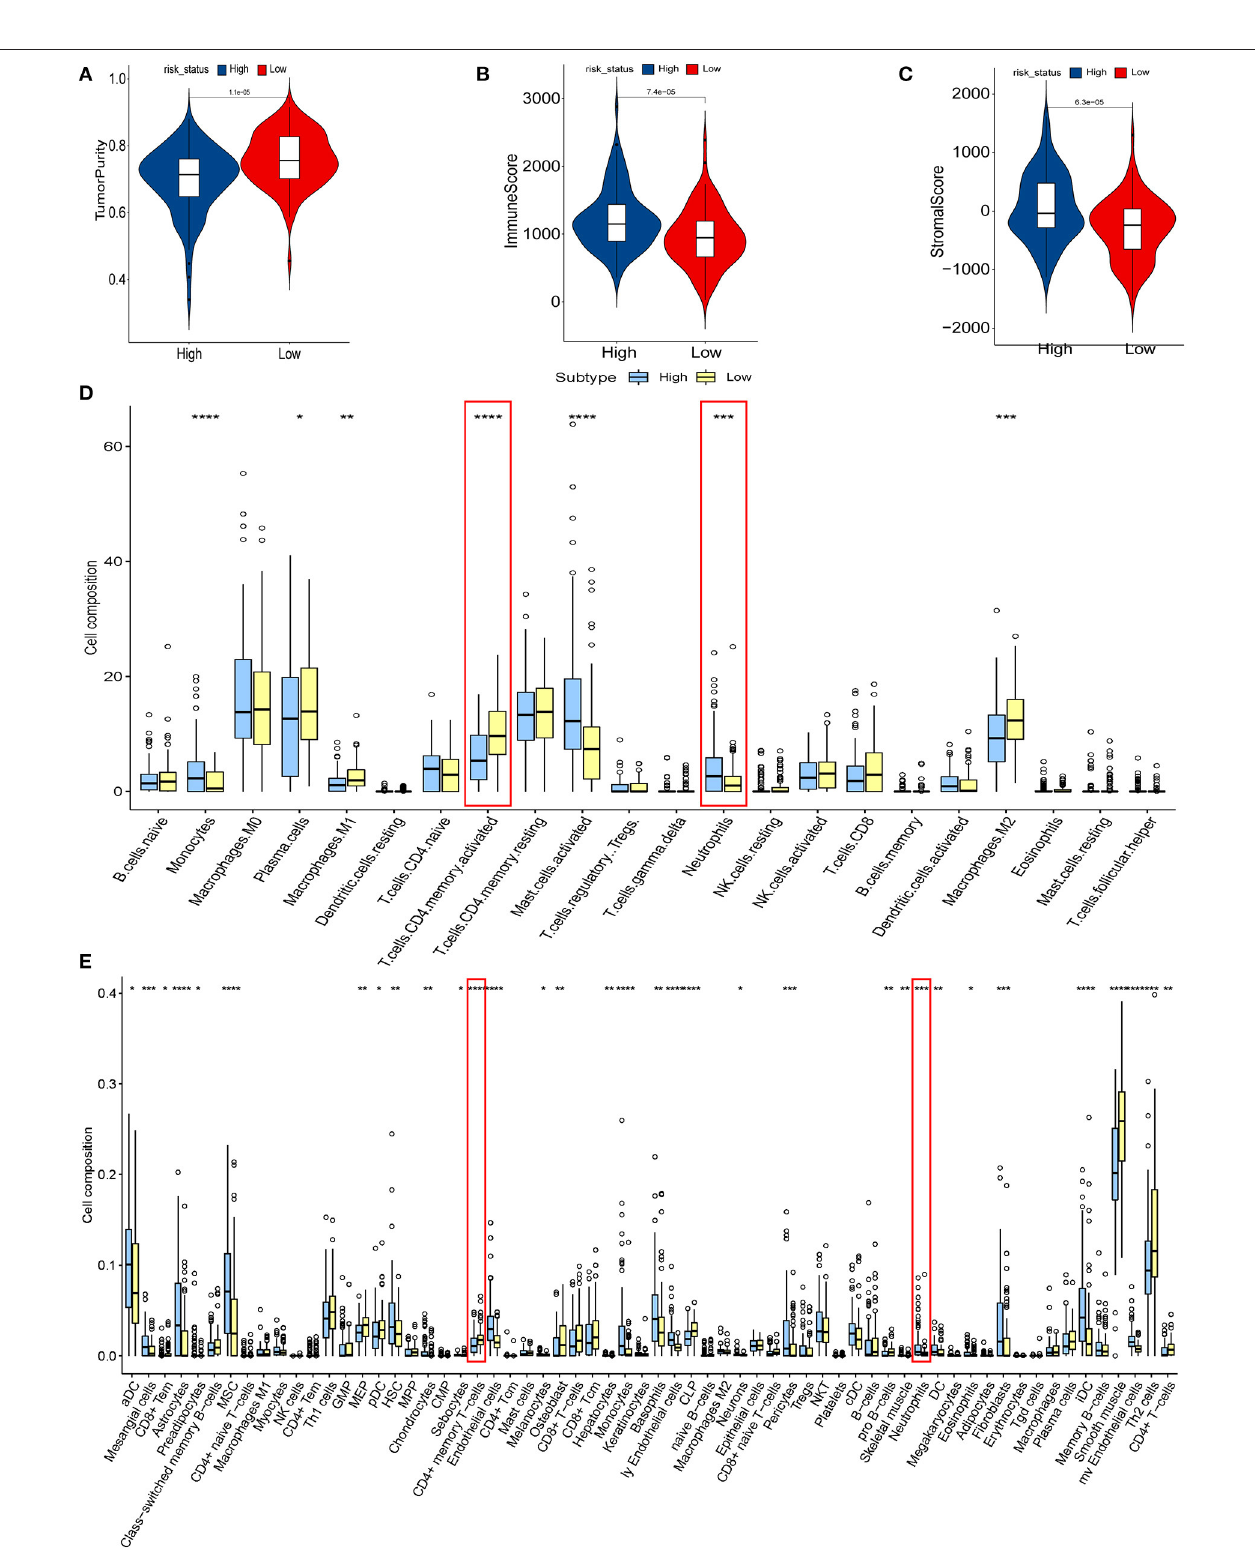
FIGURE 4 | The relationship between hypoxia and tumor-immune microenvironment in the GEO cohort. Comparison of TumorPurity (A) , ImmuneScore (B) , and StromalScore (C) between the HRisk and LRisk patients. (D) Boxplots depicting the CIBERSORT scores of 22 immune cells of the HRisk patients compared to the LRisk patients. (E) Boxplots depicting the Xcell scores of 64 immune cells of the HRisk patients compared to the LRisk patients. HRisk, high-risk; LRisk, low-risk. * P < 0.05, ** P < 0.01, *** P < 0.001, **** P < 0.0001.